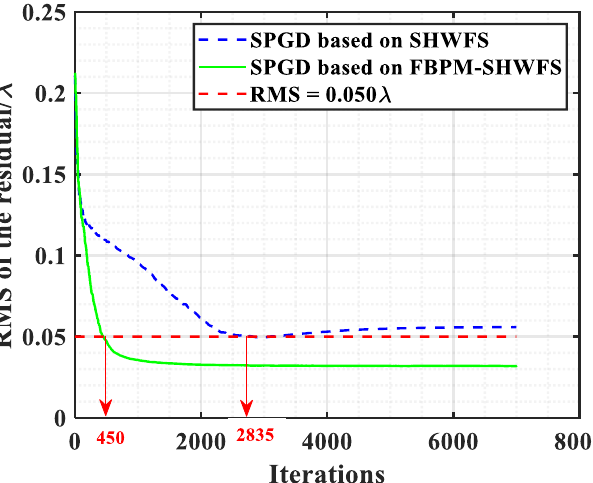
Figure 16. The RMS of the residual wavefronts as a function of iterations for both structures.